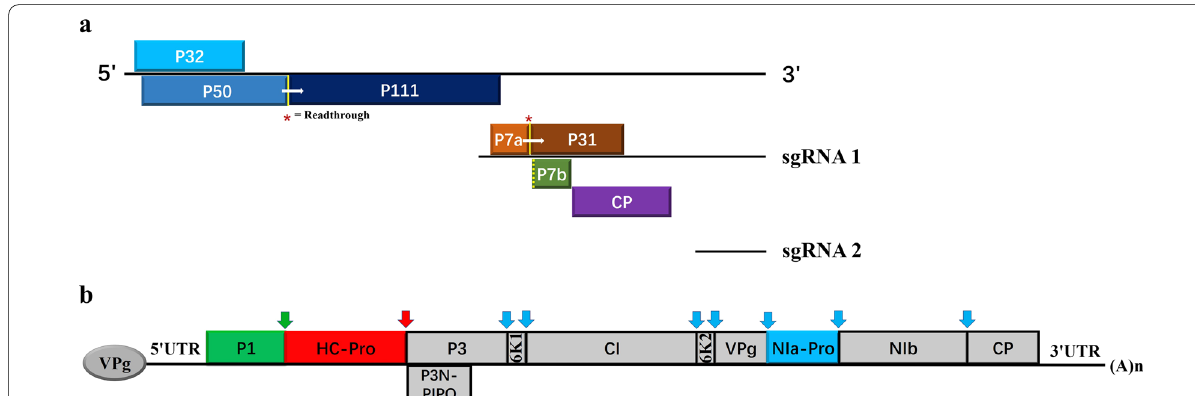
Fig. 2 Schematic diagram of the gene expression strategy of maize chlorotic mottle virus (MCMV) and sugarcane mosaic virus (SCMV). a Genomic organization of MCMV. The heavy line indicates the genomic RNA and the thinner lines represent the subgenomic RNA1/2 (sgRNA1/2). The open reading frames (ORF) are marked as boxes on the genomic RNA and sgRNA1. The vertical lines (asterisks in orange) indicate the leaky stop codons leading to translational readthrough. The dashed line (P7b) represents a non-AUG start codon. CP, coat protein. b Genomic organization of SCMV. A single large polyprotein cleaved into ten mature proteins are listed within the smaller boxes that make up the ORF. P1 protease and HC-Pro release themselves from the polyprotein and other cleavages are processed by NIa-Pro. P3N-PIPO derives from frameshifting on the P3 cistron, and (A)n represents the poly(A) tail. CI, cylindrical inclusion; HC-Pro, helper-component protease; NIa-Pro, nuclear inclusion a-protease; NIb, nuclear inclusion b; PIPO, pretty interesting Potyviridae ORF; VPg, genome-linked viral